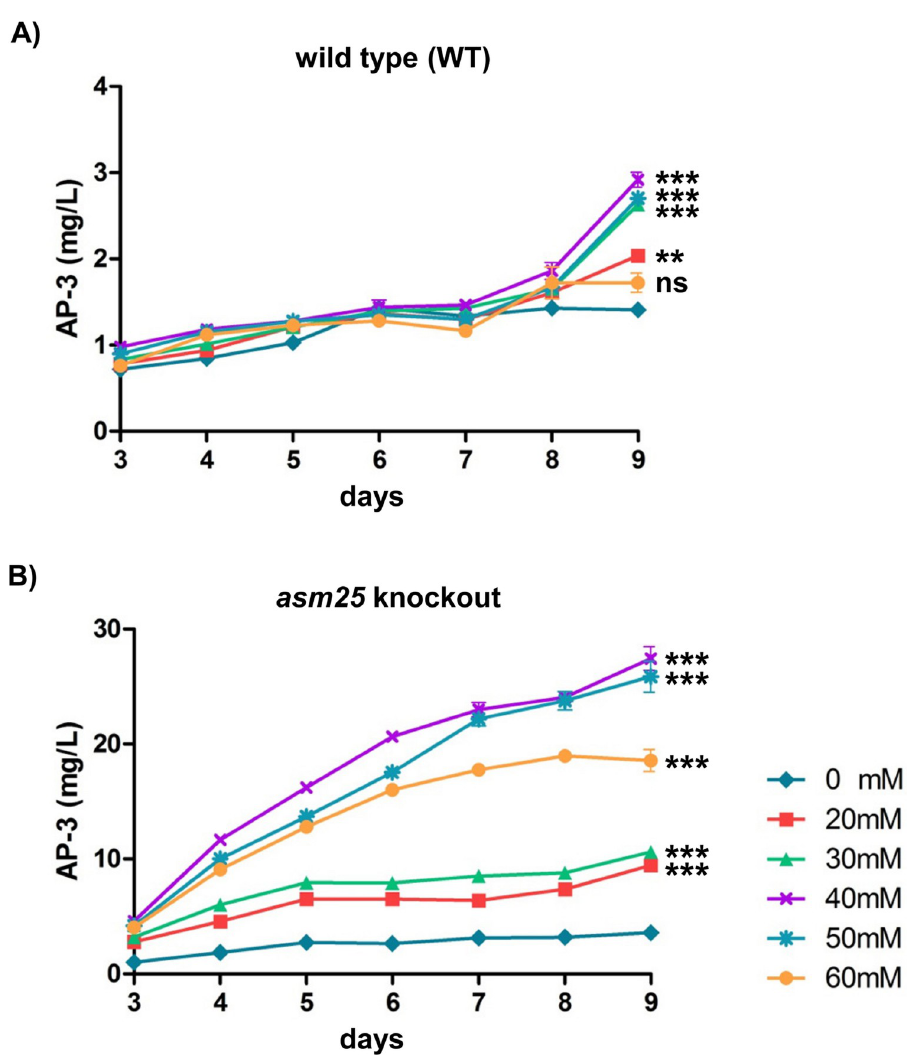
Fig 5. Determination of AP-3 yield in the presence of isobutanol. (A) AP-3 yield curve in the WT strain. (B) AP-3 yield curve in the asm25 knockout strain. Lines in color represent various concentrations of isobutanol in fermentation. The mean ± SD from three independent experiments (n = 3) are presented. The comparison and statistical analysis for AP-3 yield at Day 9 among groups were performed by the ANOVA. �� : p < 0.01; ��� : p < 0.001. (2.09 ± 0.17 mg/L versus 1.88 ± 0.23 mg/L in WT), respectively (S5 Fig). This is not puzzling